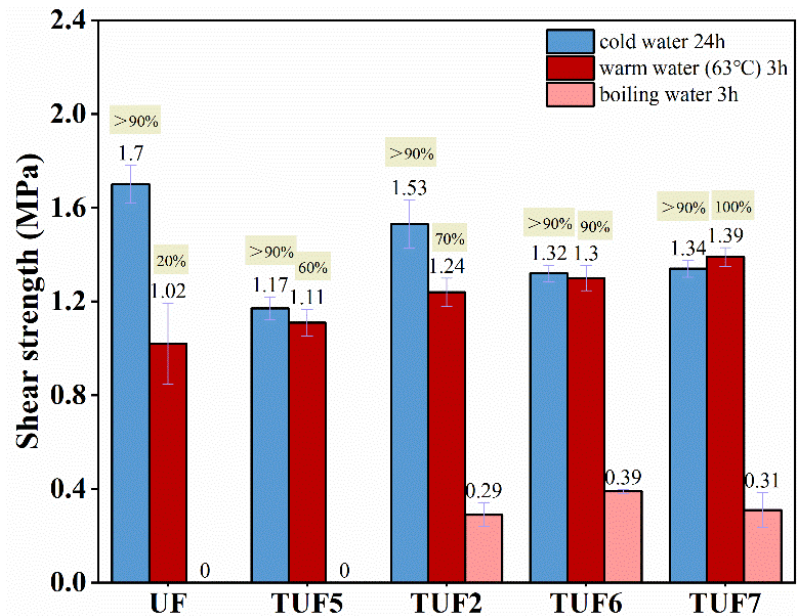
Figure 7. Shear strength of plywood specimens bonded with resin prepared via different reaction time (the highlight indicates the wood failure rate).